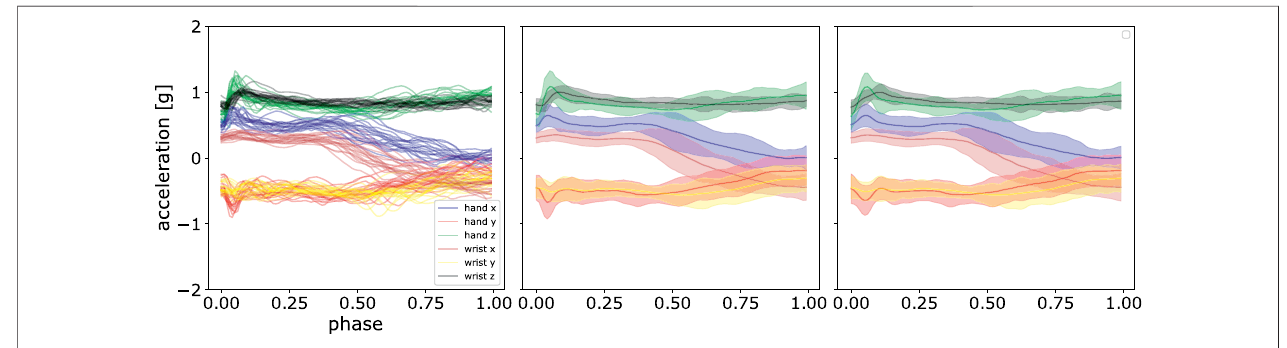
FIGURE7| Comparisonofthemeanandstandarddeviationofthepost-processedaccelerationpro fi lesandthereconstructedaccelerationpro fi lesusingProMPs. The left panel shows the data after post-processing, the middle panel displays the mean and standard deviation of that data, and in the right panel, the reconstruction using ProMPs is illustrated. The shaded area corresponds to 2 σ con fi dence interval.